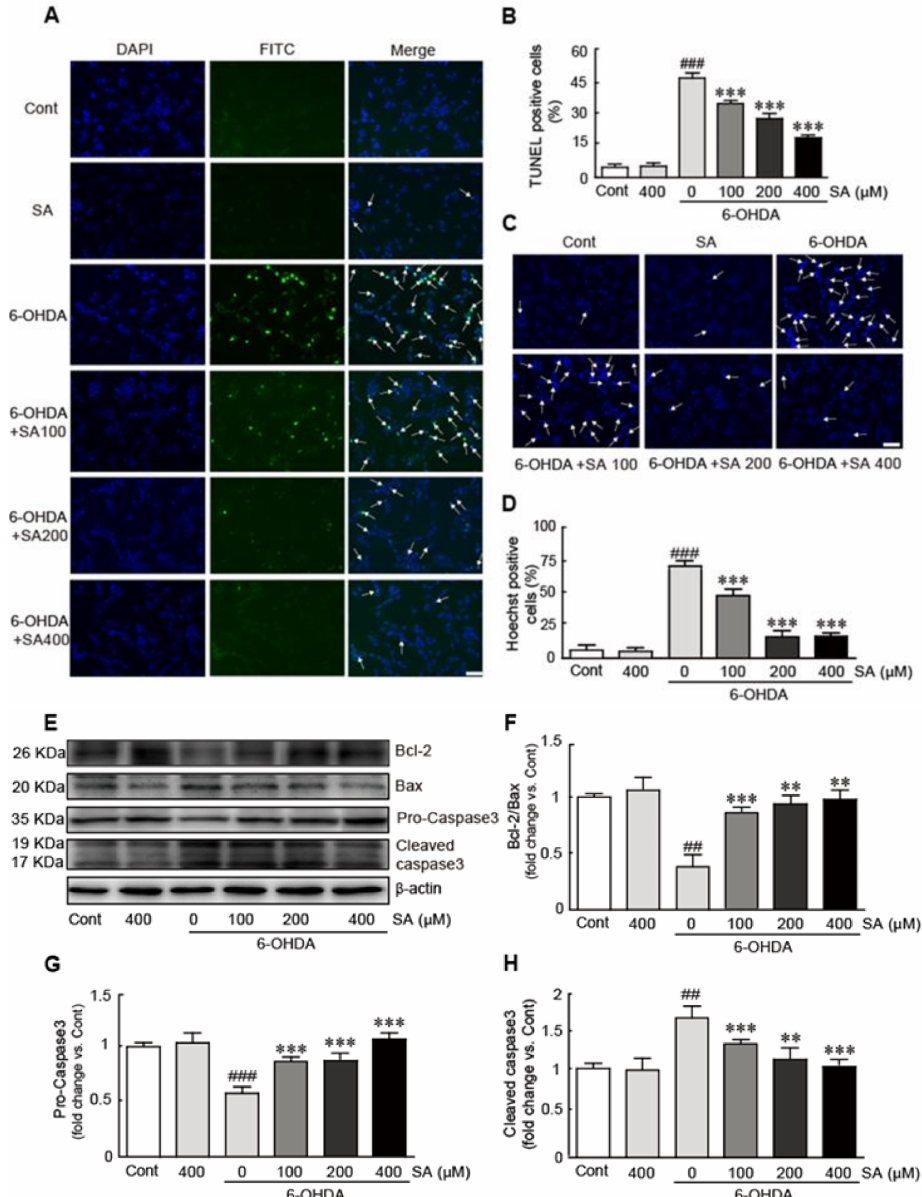
Figure 3. SA attenuates 6-OHDA-induced SH-SY5Y neuroblastoma cell apoptosis. Representative photograph of 6-OHDA- treated cells for 24 h with or without 100, 200, and 400 µ M SA pretreatment for 24 h in the TUNEL ( A ) and Hoechst staining ( C ) assays. The apoptotic index was calculated by determining the percentage of TUNEL-positive ( B ) or Hoechst-positive ( D ) cells versus the total cells. The white arrow indicates TUNEL or apoptotic-positive cells. At least 30 cells per field were counted and 10 fields were determined in each group for TUNEL and Hoechst staining analysis. The cells were observed under 200 × magnification. ( E ) Western blot analysis was performed to measure the expression levels of Bcl-2, Bax, pro-, and cleaved caspase 3 proteins in SA-pretreated/6-OHDA-treated cells. The expression levels of Bcl-2 ( F ), Bax ( F ), pro- ( G ), and cleaved ( H ) caspase 3 proteins were quantified with HD imaging software. β -actin was used as the loading control. Western blot analysis was performed in triplicate with three independent samples. All data were reported as the mean ± standard error of the mean (SEM). Significance was determined via a one-way ANOVA coupled with Bonferroni’s post hoc test. ## p < 0.01 and ### p < 0.001 vs. control group. ** p < 0.01 and *** p < 0.001 vs. 6-OHDA-only-treated group. Cont, control; SA, sinapic acid; 6-OHDA, 6-hydroxydopamine; Bcl-2, B-cell lymphoma 2; Bax, Bcl2-associated X protein. Scale bar, 100 µ